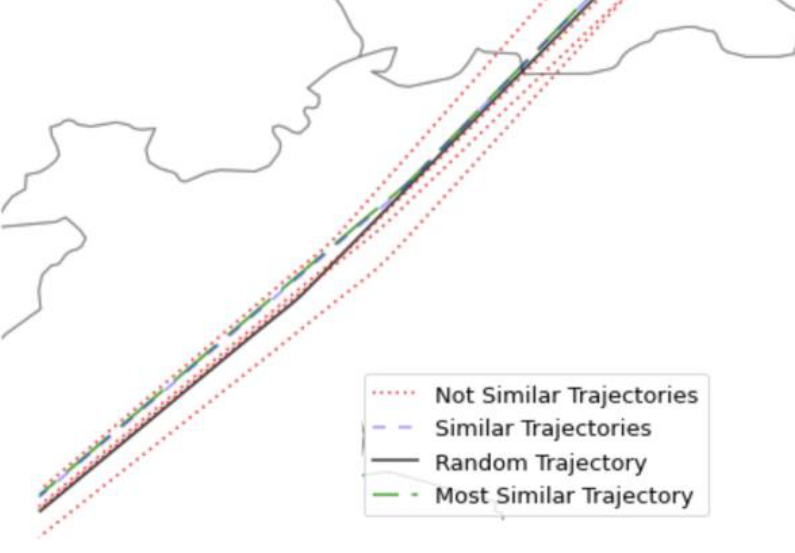
Figure 3. Representation of the selection of 4DT predictions. Once the 4DT prediction is selected from the ADS-B database, two modifications are made to ease the interoperability. The first modification is about a resample of the 4DT prediction to reduce the number of samples that constitute the prediction. The goal of the resample is to reduce the computational workload and the size of the final database to consider due to the high number of samples. The resample is not an issue in the case where the aircraft fly straight lines, but if the aircraft is turning or performing a manoeuvre, it will not be reflected